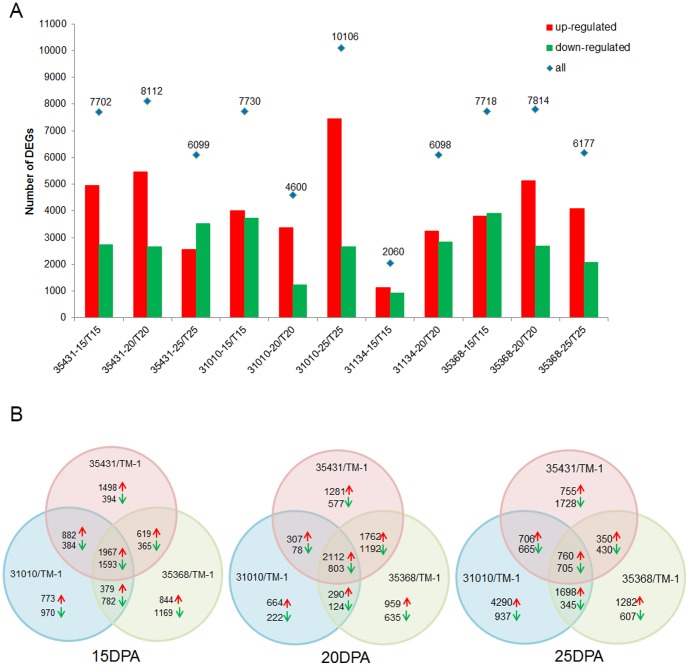
Statistical of DEGs between CSILs and TM-1 at 15, 20 and 25 DPA.(A) Up-regulated and down-regulated genes in different comparison. Red bar, up-regulated genes compared to TM-1; green bar, stand for down-regulated genes compared to TM-1, Blue square, total DEGs. CSILs included CSIL-35431, CSIL-3010, CSIL-31134, CSIL-35368 and TM-1. 15, 15DPA; 20, 20DPA; 25, 25DPA. (B) Common and special DEGs at 15 DPA, 20 DPA and 25 DPA.